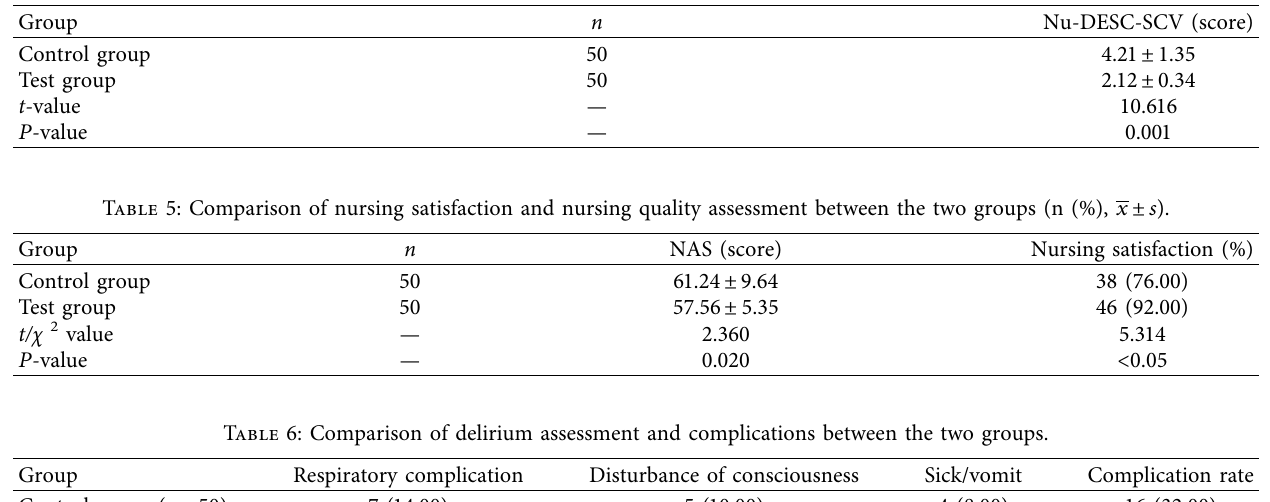
Table 4: Comparison of delirium assessment between the two groups ( x ± s ).